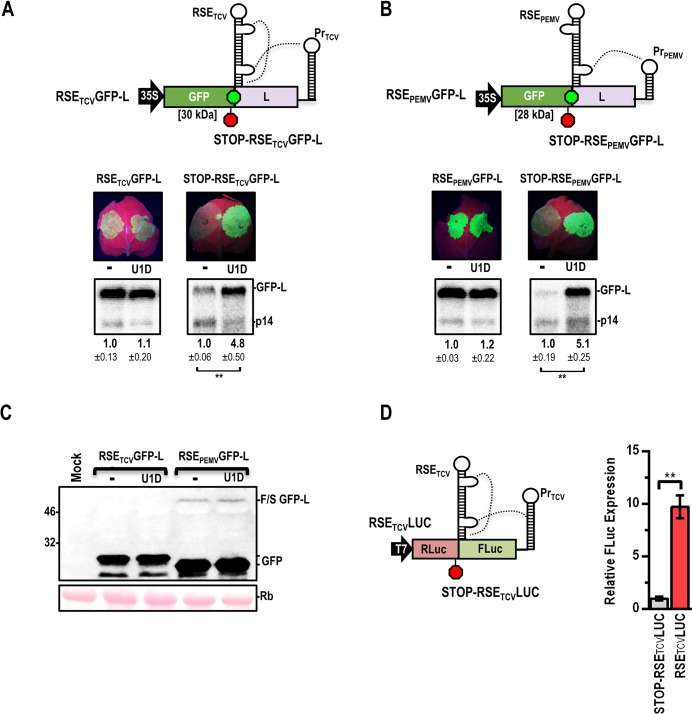
Viral ribosome recoding elements can stabilize NMD-sensitive transcripts.(A) Top, TCV ribosome readthrough element (double bulged hairpin), the adjacent stop codon (green hexagon) and an upstream conserved hairpin (not shown) were placed just downstream of the GFP ORF in GFP-L (RSETCVGFP-L) along with the TCV 3’ proximal Pr hairpin. STOP-RSETCVGFP-L contains an additional stop codon (red hexagon) upstream of the RSE. Bottom, accumulation of transcripts in agroinfiltrated N. benthamiana in the presence and absence of U1D along with p14. (B) Top, PEMV-2 ribosome frameshifting element and upstream conserved hairpin (not shown) were placed just downstream of the GFP ORF generating RSEPEMVGFP-L. STOP-RSEPEMVGFP-L contains an additional stop codon immediately upstream of the RSE cassette. Bottom, results from agroinfiltration. Data from panels A-B are from three independent infiltrations and standard deviation is shown. See legend to Fig 2B for additional information. (C) Detection of ribosome-recoded proteins in infiltrated tissue by western blots using a GFP antibody. GFPs expressed from the TCV and PEMV constructs migrate differently as the sequences upstream of their respective RSEs differ in size. Rb, Ribulose bis-phosphate carboxylase. (D) Left, RSETCV and STOP-RSETCV cassettes were ligated into a dual-luciferase vector containing the TCV 3’ UTR. Right, dual-luciferase RNAs were translated in WGE and relative FLuc expression was determined. STOP-RSETCVLUC FLuc expression was set to 1.0. Data are from four independent samples and standard deviation is shown. Unpaired t test: ** p<0.01.